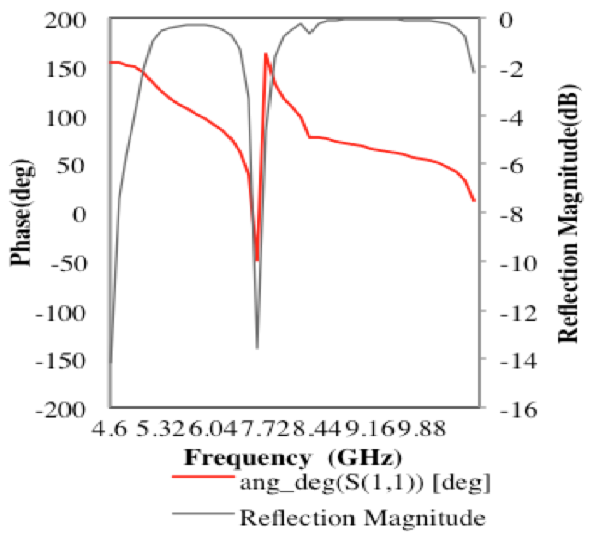
reduced by 81.5% is shown in table1. Figure 3: The reflection phase and magnitude of AMC at 5.5 GHz, 6.81 GHz and 9.3 GHZ